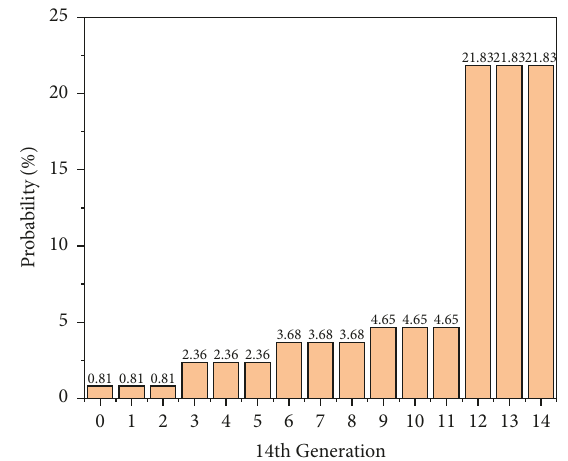
Figure 2: Change trend of probability in